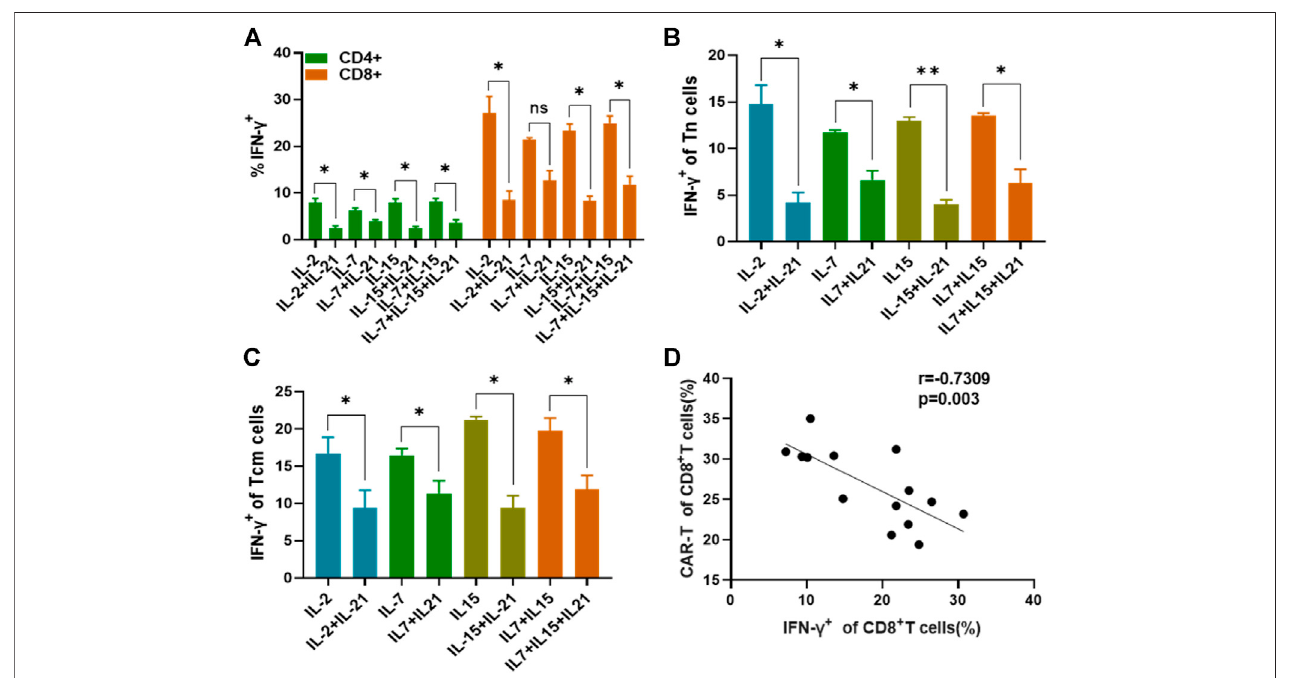
FIGURE 5 | IFN- γ expression affects T cell transfection ef fi ciency. (A) The IFN- γ expression of CD4 + T cells and CD8 + T cells among different cytokines groups was evaluated on day 2 after activation by fl ow cytometry. (B,C) The percentages of IFN- γ -producting T cells in the Tn and Tcm subtypes were analyzed at 48th after stimulation. (D) Analysis of the correlation between the percentage of IFN- γ + CD8 + T cells at 48 h after stimulation and transduction ef fi ciency of CD8 + T cells using a Spearman rank correlation test was shown. All experiments were performed in triplicate manner and percentage was statistically analyzed. * p < 0.05, ** p < 0.01, Error bars represent ± SEM.